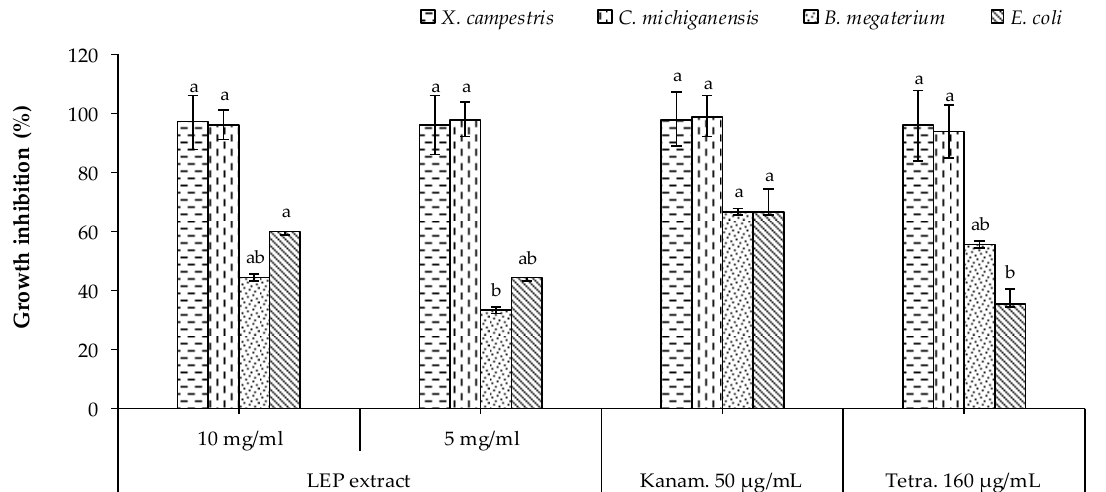
Figure 1. Antibacterial activity of the leathery exocarp (LEP) extract. Bars with different letters indicate mean values significantly different at p < 0.05, according to a one-way ANOVA combined with Tukey’s B post-hoc test. Data are expressed as the mean of three replicates ± SD.